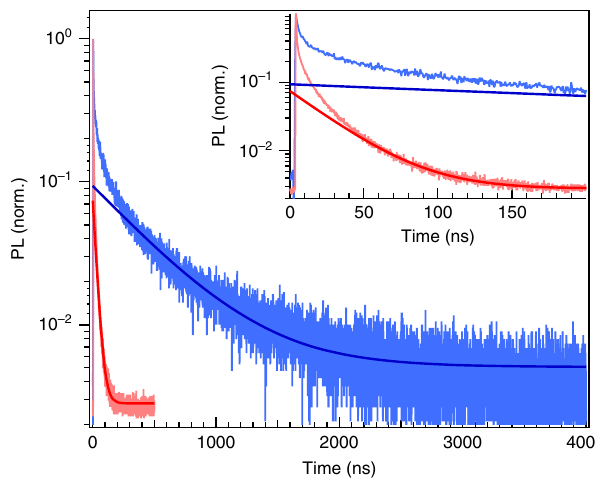
Fig. 4 Normalized photoluminescence (PL) decays for CH 3 NH 3 PbBr 3 . Thin fi lm ( red ) and single crystal ( blue ) excited at 447nm. The tails of the decay are fi tted with an exponential decay function with constants k = 2.1 × 10 6 s − 1 and k fi = 3.6 × 10 7 s − 1 . Inset : zoom on shorter time SC lm